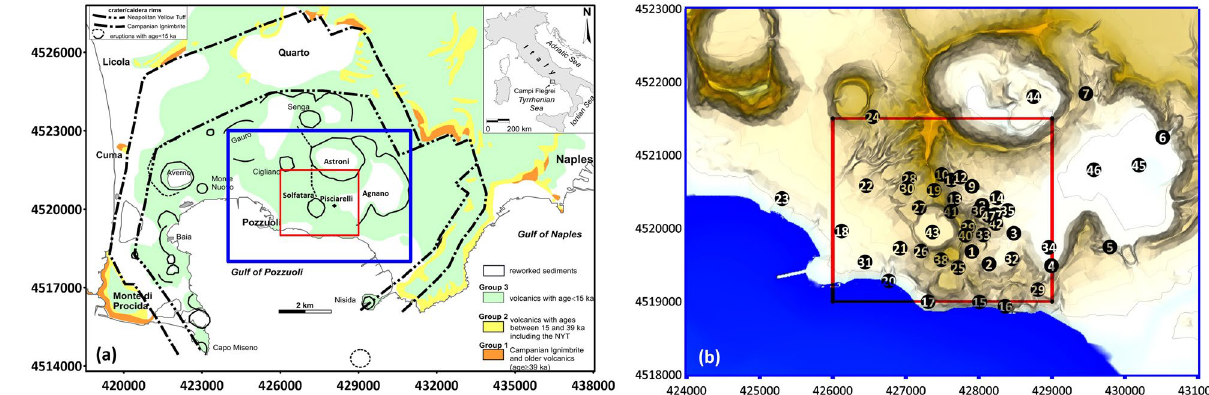
Figure 1. ( a ) Map of the Campi Flegrei caldera. Black lines indicate the main morphostructural features of the caldera. The area framed in the blue box has been magnified in panel ( b ); the red box indicates the investigated area ( b ) Map of the area subject of the MT surveying. The red square frame the investigated area. Black circles indicate the location of the MT